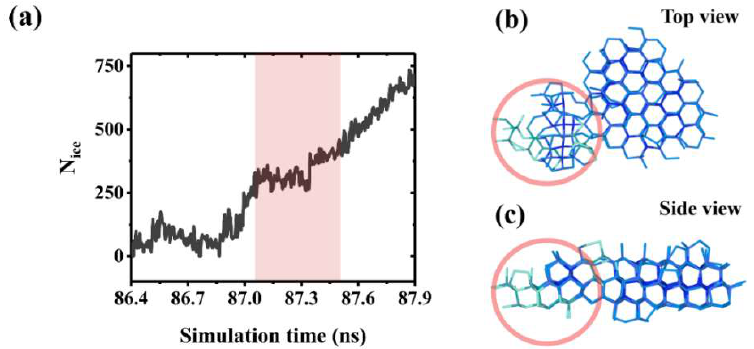
Figure 6. Stunting effect of a boundary misorientation during ice growth. ( a ) The inset shows the stunting period (shaded red) in the ice growth process caused by boundary misorientation between ice crystals. ( b ) Top view snapshots of boundary misorientation between ice crystals. ( c ) Side view of the boundary misorientation between ice crystals.